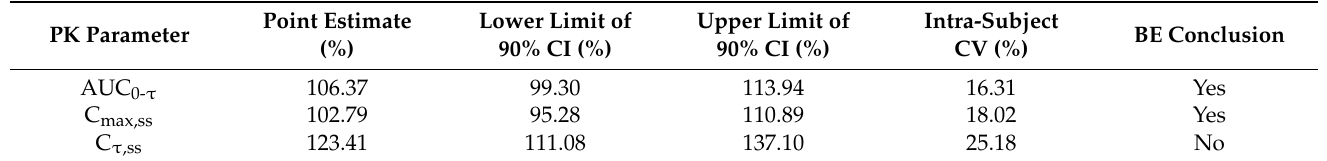
Table 4. Bioequivalence evaluation of desvenlafaxine 100 mg prolonged-release tablets at the simu- lated steady state, after a once-daily schedule in fasted state in 32 healthy volunteers. PK